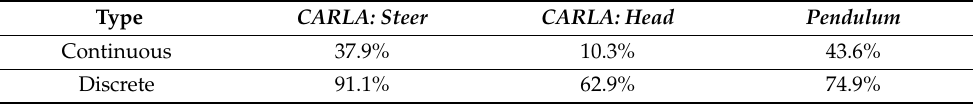
Table 2. Improvement over the baseline SAC by continuous and discrete human expert feedback in the CARLA environment and algorithmic expert feedback in the Pendulum environment. Type CARLA: